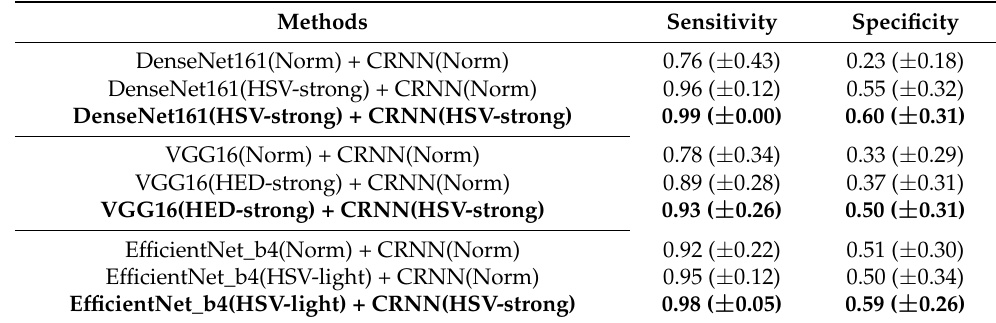
Table 3. Inference results for the cascaded CNN + CRNN(ResNet152+LSTM) architectures.